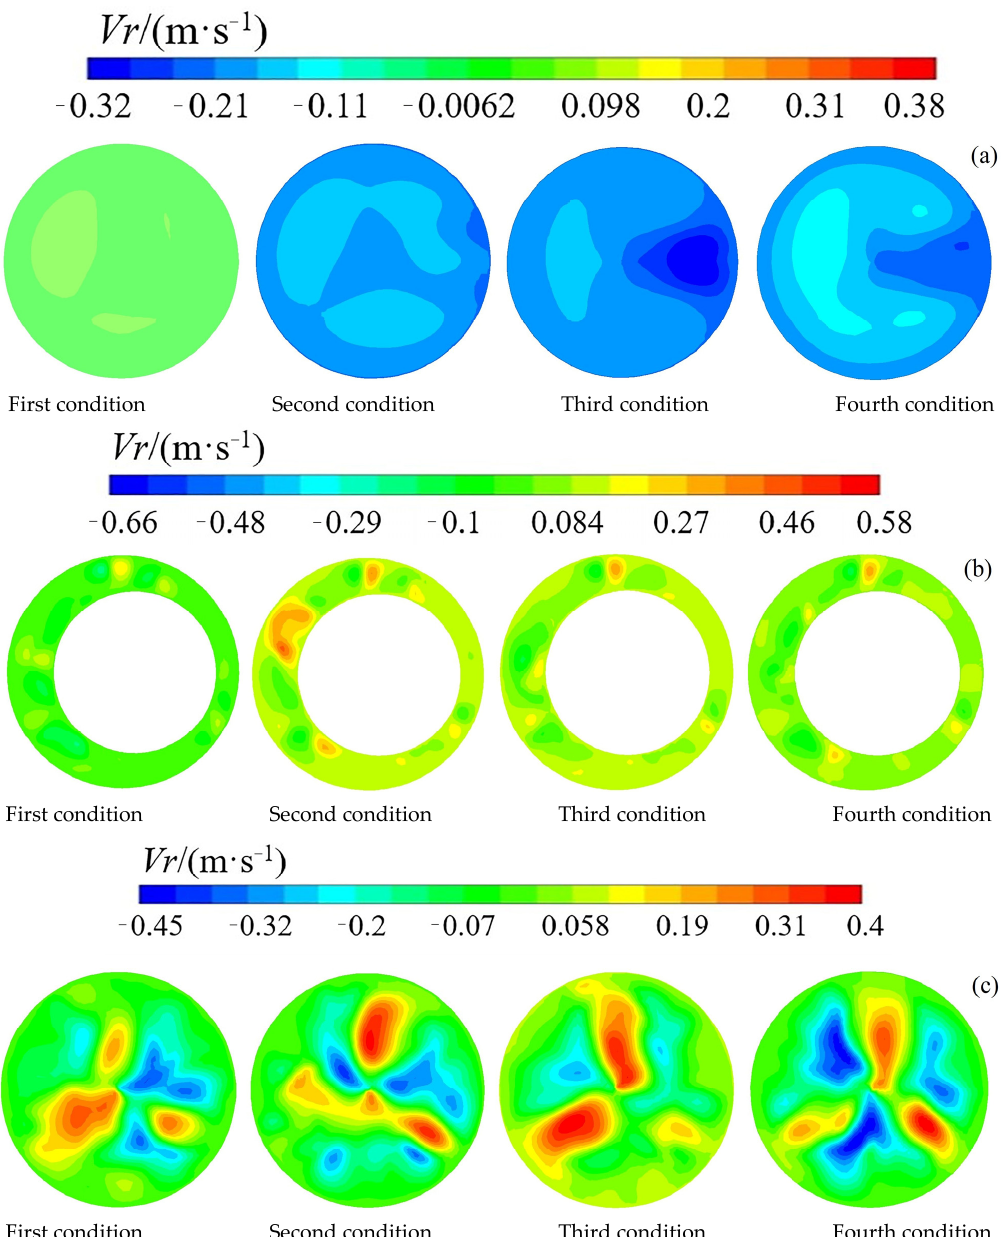
Figure 9. The radial flow velocity distribution cloud map of the characteristic section when the pipeline truck starts at different positions of the pipe bend (the conditions meaning the centroid of the wheeled capsule had angle locations of θ ): ( a ) upstream of the wheeled capsule; ( b ) gap zone between the capsule and the pipe; ( c ) downstream of the wheeled capsule.